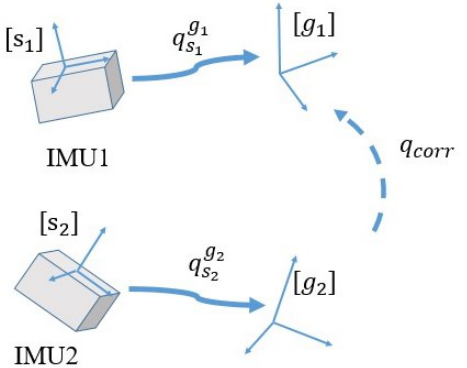
Figure 8. Schematic figure of correction quaternion for the reference frames’ deviations, where [ g 1 ] , [ g 2 ] denote reference frames estimated by IMU1’s and IMU2’s